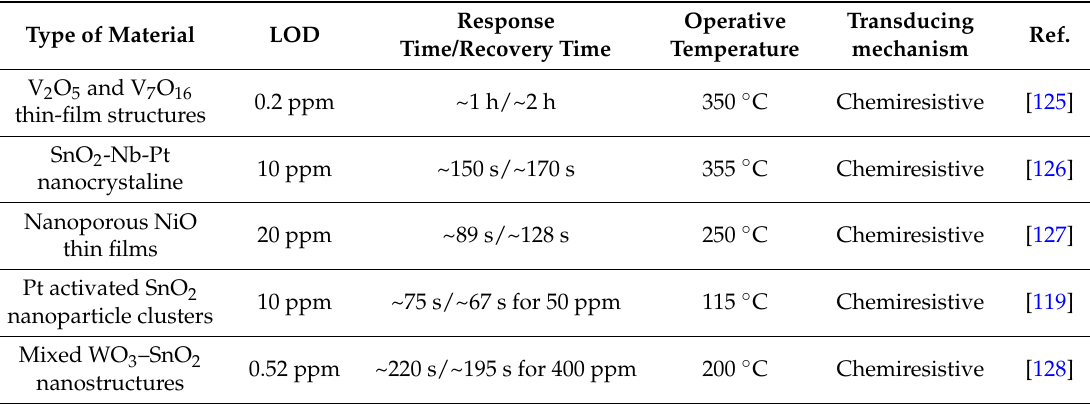
Table 5. Overview of different nanomaterials used as active layers for detection of ammonia at higher